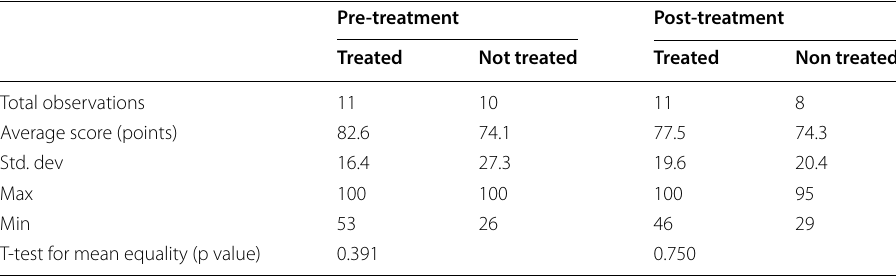
Table 2 Italian test scores: pre- and post-treatment descriptive